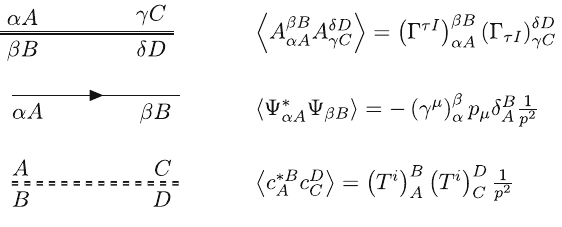
Fig. 1 Feynman rules for the